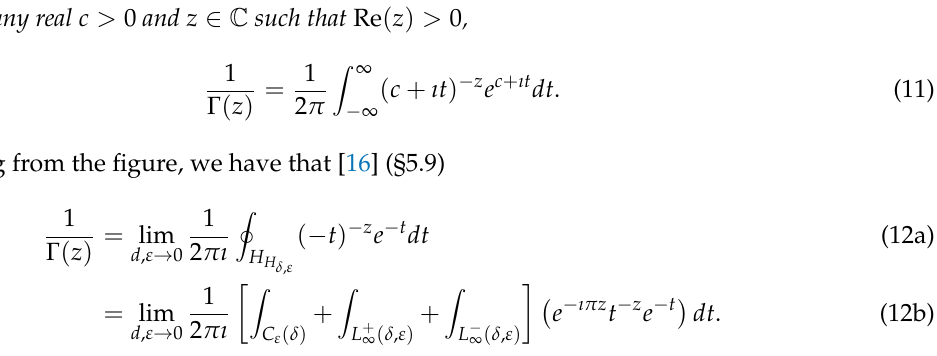
Figure 1. The Hankel loop contour providing an integral representation of the reciprocal gamma function when Re ( z ) > 0. This contour starts positively from the right, traverses the horizontal line (cid:112) | ε 2 − δ 2 | , then enters the semi-circular loop about L + ∞ ( δ , ε ) at distance + δ from the x -axis from + ∞ → (cid:112) | ε 2 − δ 2 | , − δ ) the origin of radius ε denoted by C ε ( δ ) at the point P 1 , and then at the point P 2 = ( traverses the last horizontal line L − ∞ ( δ , ε ) back to infinity parallel to the x